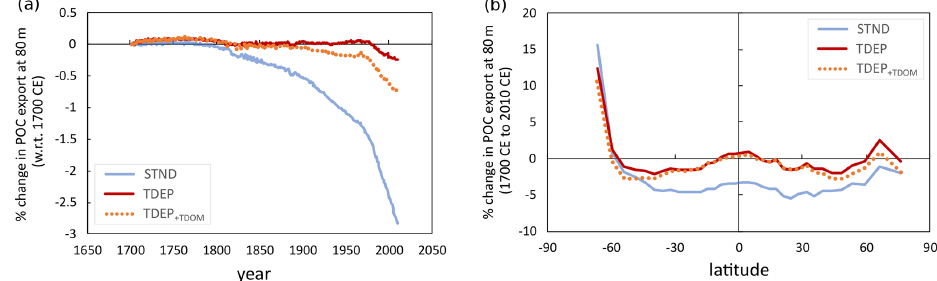
Figure 14. POC export at 80m (percent change with respect to the year 1700): (a) global mean POC export at 80m and (b) latitudinal mean POC export change at 2100 with respect to 1700CE. STND is the standard model, and TDEP is the temperature-dependent model, TDEP + TDOM is temperature-dependent POM and DOM and is described in Sect. 5.2.